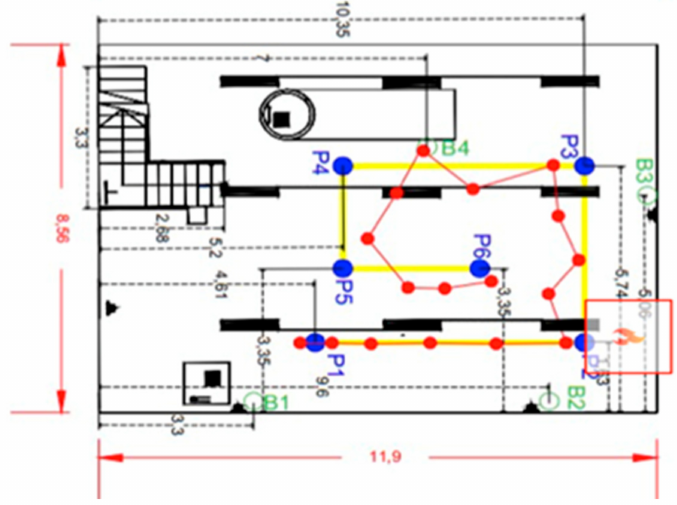
Figure 10. USC map with location results.